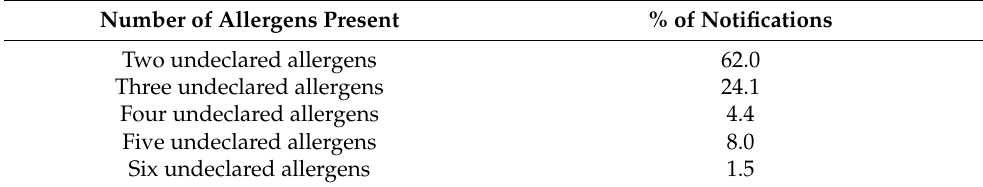
Table 2. Percentage of RASFF notifications that informed about food products that simultaneously contained two or more undeclared allergens between 1 January 2018 and 31 December 2021. Number of Allergens